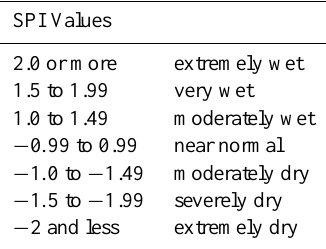
Table 3. SPI Values and drought